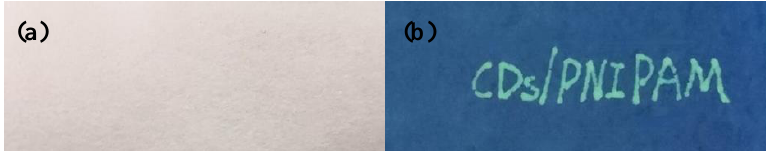
Figure 12. Written “CDs / PNIPAM” on filter paper by CDs / PNIPAM used as the fluorescent ink. ( a ) Daylight lamp; ( b ) 365 nm ultraviolet lamp.